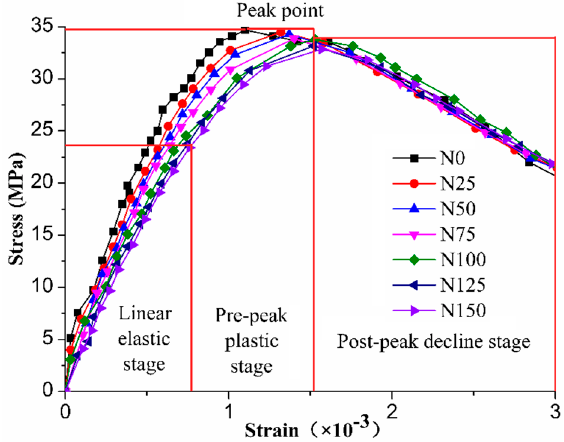
Figure 4. Stress–strain curve of concrete under different numbers of freezing–thawing cycles.